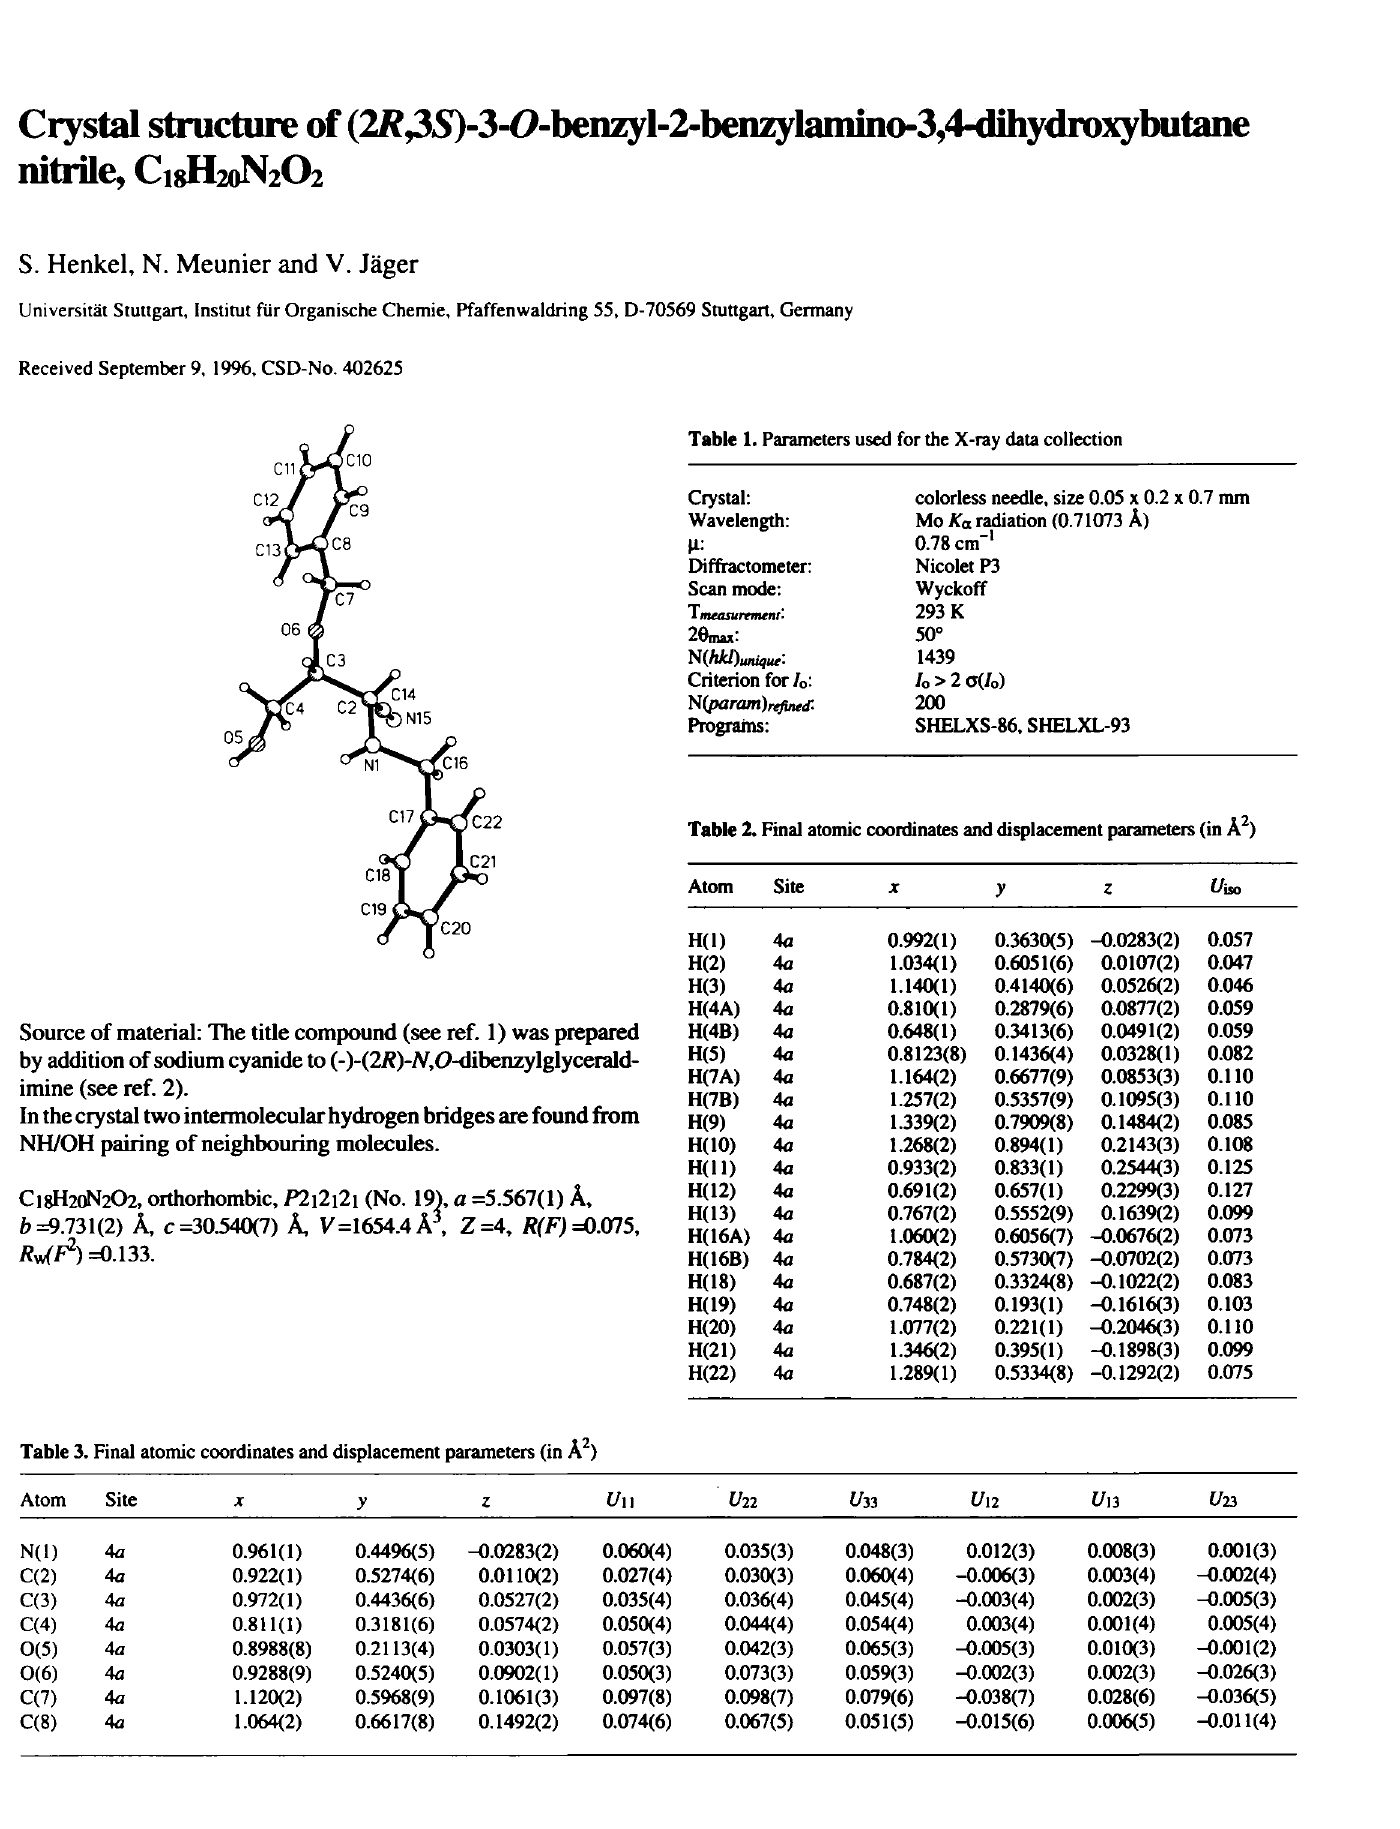
Table 3. Final atomic coordinates and displacement parameters (in A 2 ) Atom